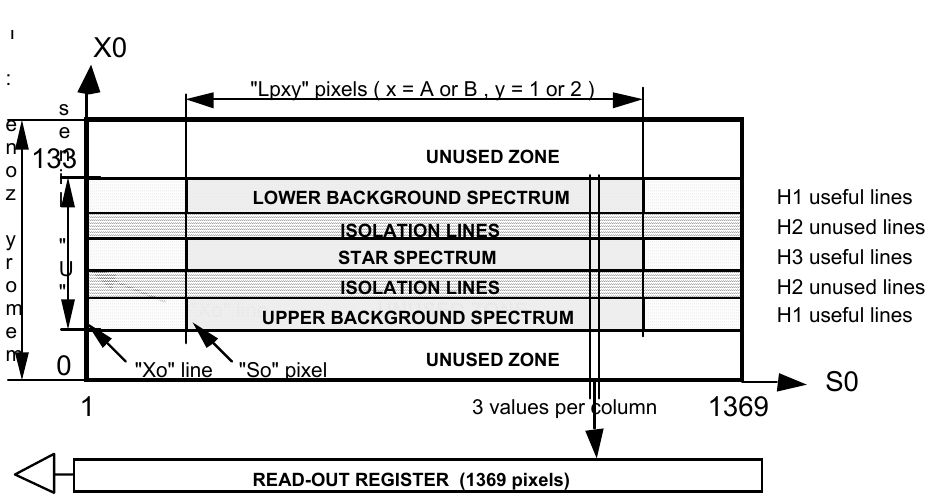
Fig. 6. Spectrometer’s CCD reading for occultation mode. During the nominal mission of GOMOS, the interband region was fixed at H1=3 CCD lines, and the three bands are with H1=H3=7